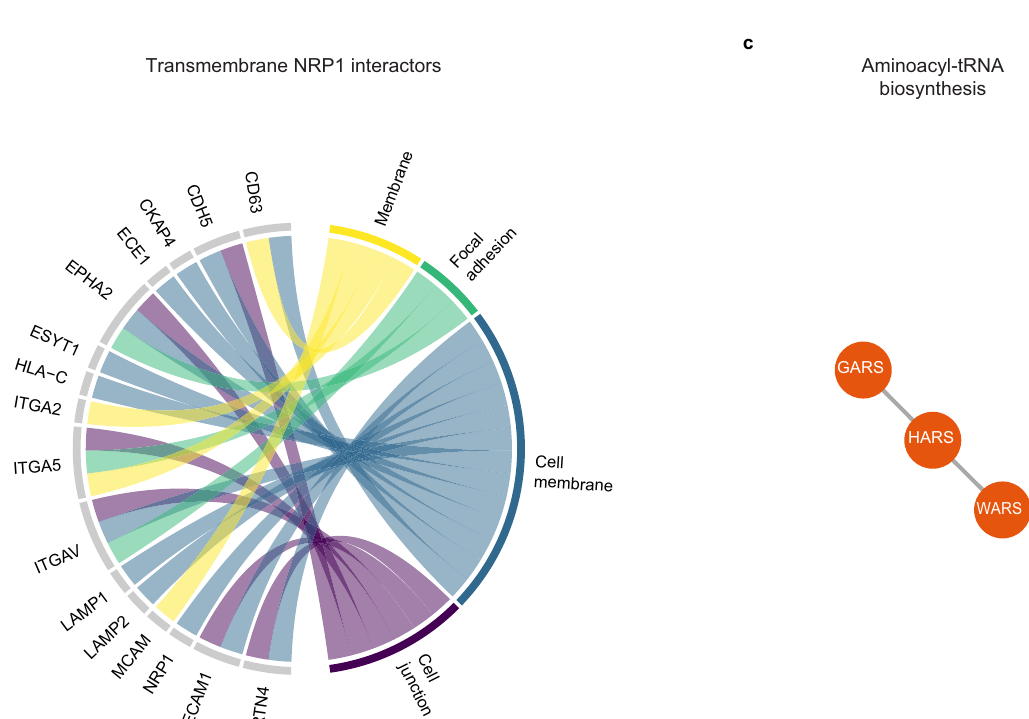
Fig. 2 NRP1 interactome. a Schematic drawing summarizing the role of NRP1 as a pro-endocytic receptor 20,22,23,33 that promotes the internalization and recycling of associated plasma membrane receptors, such as integrins 20,33 and other still to be identi fi ed receptors (in gray). b Cell adhesion receptors as preferential potential transmembrane NRP1 interactors. Chord diagram of transmembrane proteins found to interact with NRP1. Each protein was assigned to one or more subcellular locations based on UniProt annotation. In addition, to associate with transmembrane proteins mediating or regulating EC adhesion, NRP1 also associated with the endoplasmic reticulum reticulon 4 (RTN4) transmembrane protein that promotes cell adhesion by regulating integrin traf fi c 101 . Moreover, our identi fi cation of the transmembrane metallopeptidase endothelin converting enzyme-1 (ECE1) as a NRP1 partner on the EC surface may suggest that the TBX1-independent control of cardiac OFT morphogenesis by endothelial NRP1 102 may involve ECE1 103,104 , which functions by degrading receptor-bound extracellular ligands upon endocytosis (Supplementary Data 1). c Aminoacyl-tRNA proteins were found to be signi fi cantly enriched in the NRP1 interactome, after excluding transmembrane ( b ) and endosomal (Supplementary Fig. 2a) NRP1 interactors. STRING was used to perform enrichment analysis of KEGG pathways and to determine the physical and functional protein-protein interactions that de fi ne the edges between nodes. The plots was generated with R. Source data are provided as a Supplementary Data fi